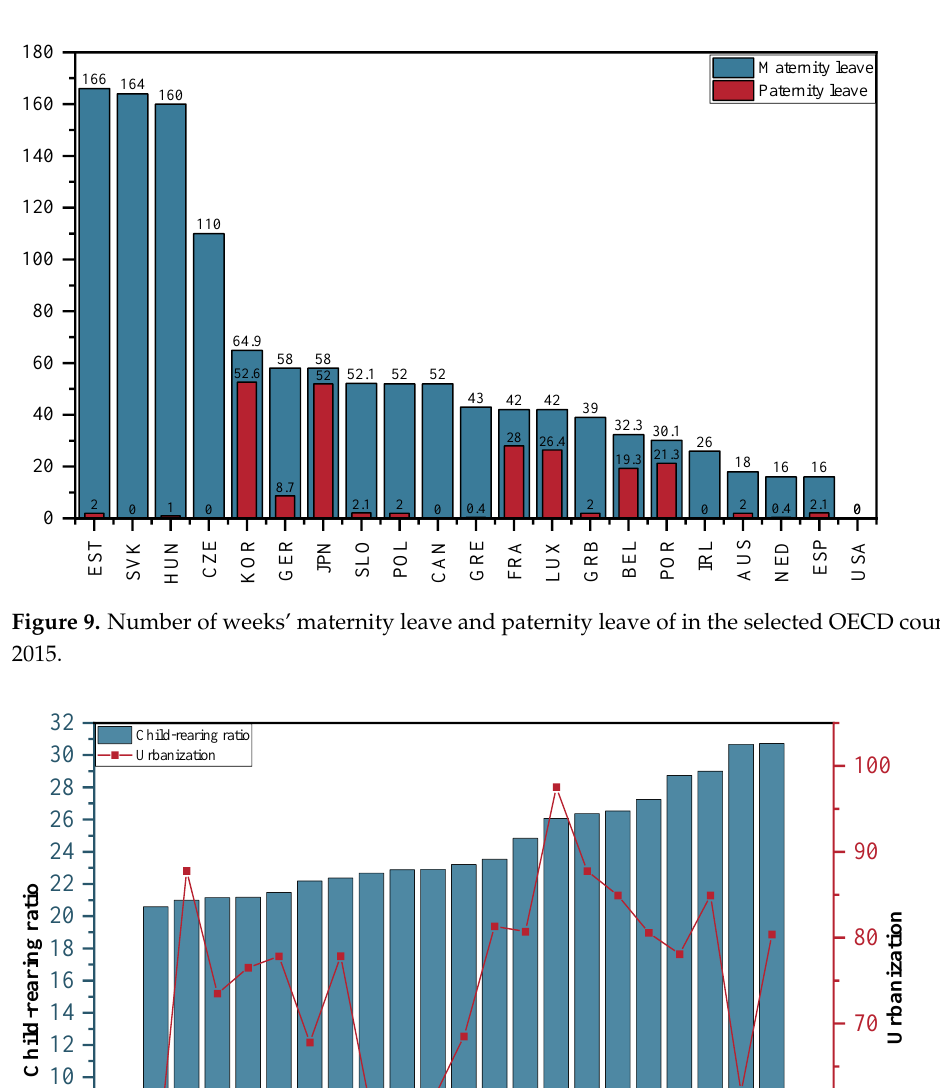
Figure 9. Number of weeks ’ maternity leave and paternity leave of in the selected OECD countries, 2015.